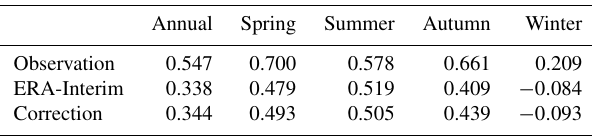
Table 9. Trends ( ◦ C10a − 1 ) of annual and seasonal T min over the 24 sites in